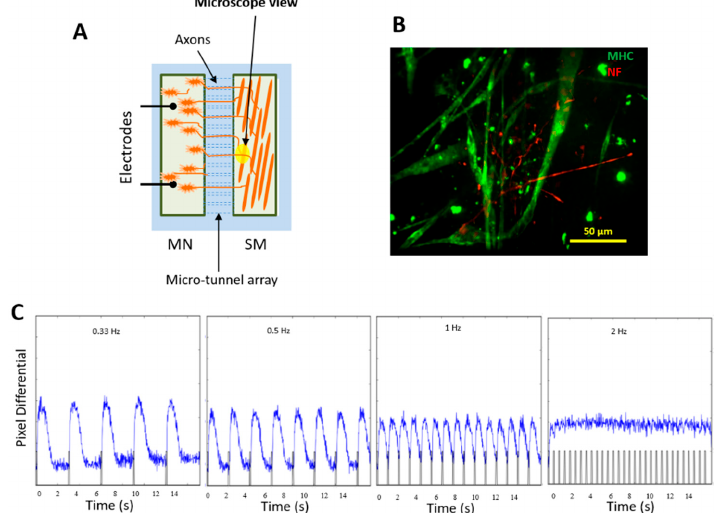
Figure 8. Innervation of iPSC-SKM by iPSC-MNs derived from the same iPSC line. ( A ) A diagram of the NMJ chamber (a courtesy from Santhanam et al. [18]). ( B ) iPSC-derived muscle culture was incorporated into the NMJ chamber system and co-cultured with motoneurons derived from the same iPSC line. Myotubes and MN axons in the muscle chamber were visualized in the muscle chamber through immunostaining utilizing antibodies against MHC (green) and Neurofilament (red) respectively. Analysis was done on Day 12 of the co-culture. The extensive distribution of axonal terminals in the muscle chamber and their physical interactions with myofibers was demonstrated by immunostaining with antibodies against Neurofilament and myosin heavy chain. ( C ) Innervated myofibers contracted in response to motoneuron stimulation under all frequencies tested.